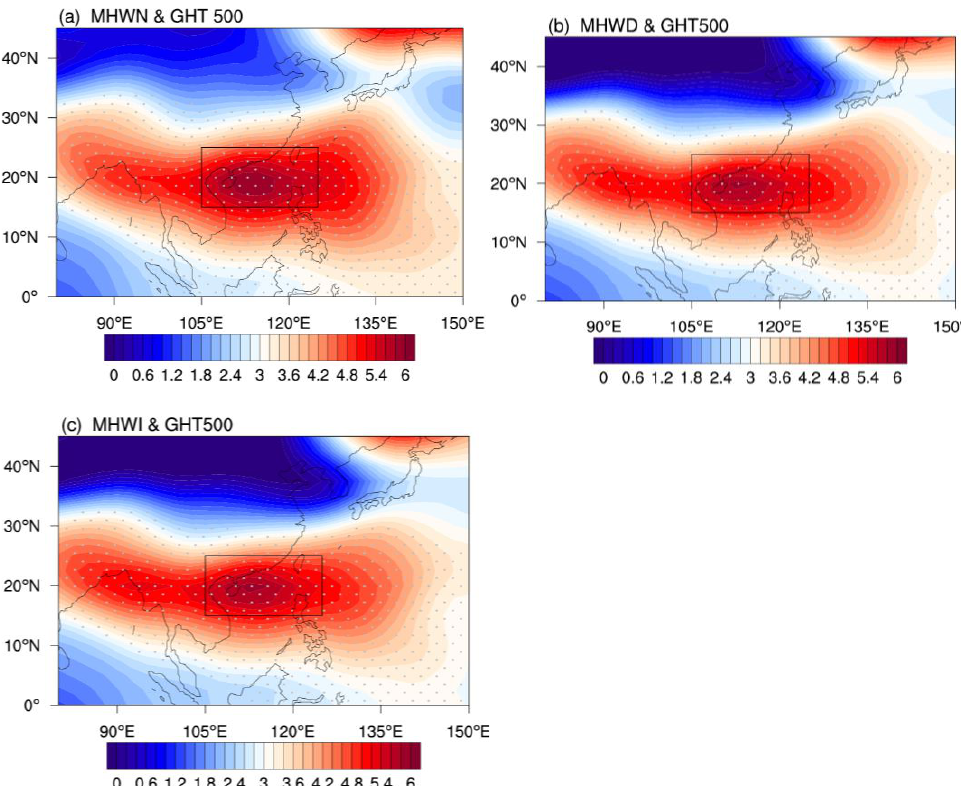
Figure 9. The GHT500 anomalies (shaded, units: gpm) and the WNPSH represented by a black con- tour of 5870 gpm in the warm season (May – September) 1982 – 1992 ( a ) and 2010 – 2020 ( b ). Anomalies are relative to the mean climatology of May – September 1983 – 2012. The mean position of WNPSH is denoted by the green contour line of 5870 gpm and the blue contour line of 5880 gpm at 500-hPa.